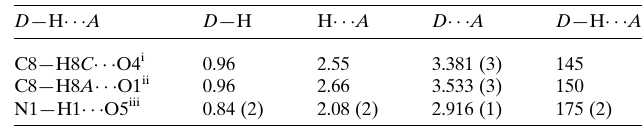
Table 1 Hydrogen-bond geometry (A˚ , (cid:5) ).